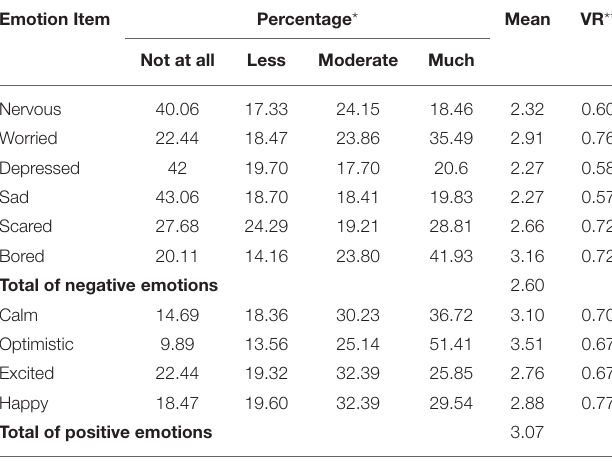
TABLE 7 | Negative and positive emotions since the onset of COVID-19 ( n =